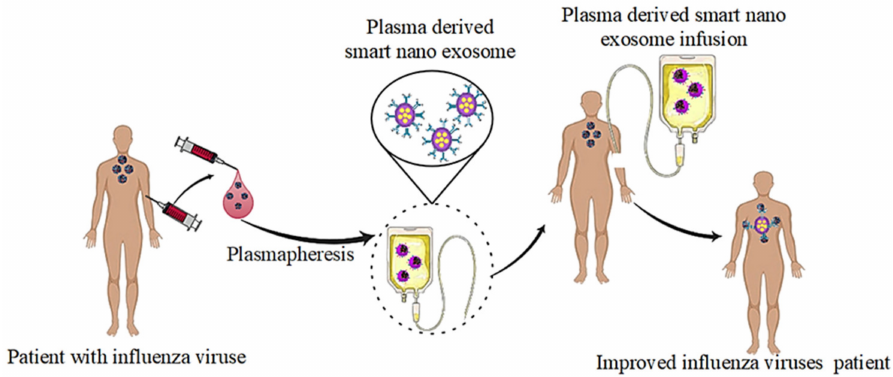
Figure 4. Improved influenza virus of a patient by plasma-derived smart